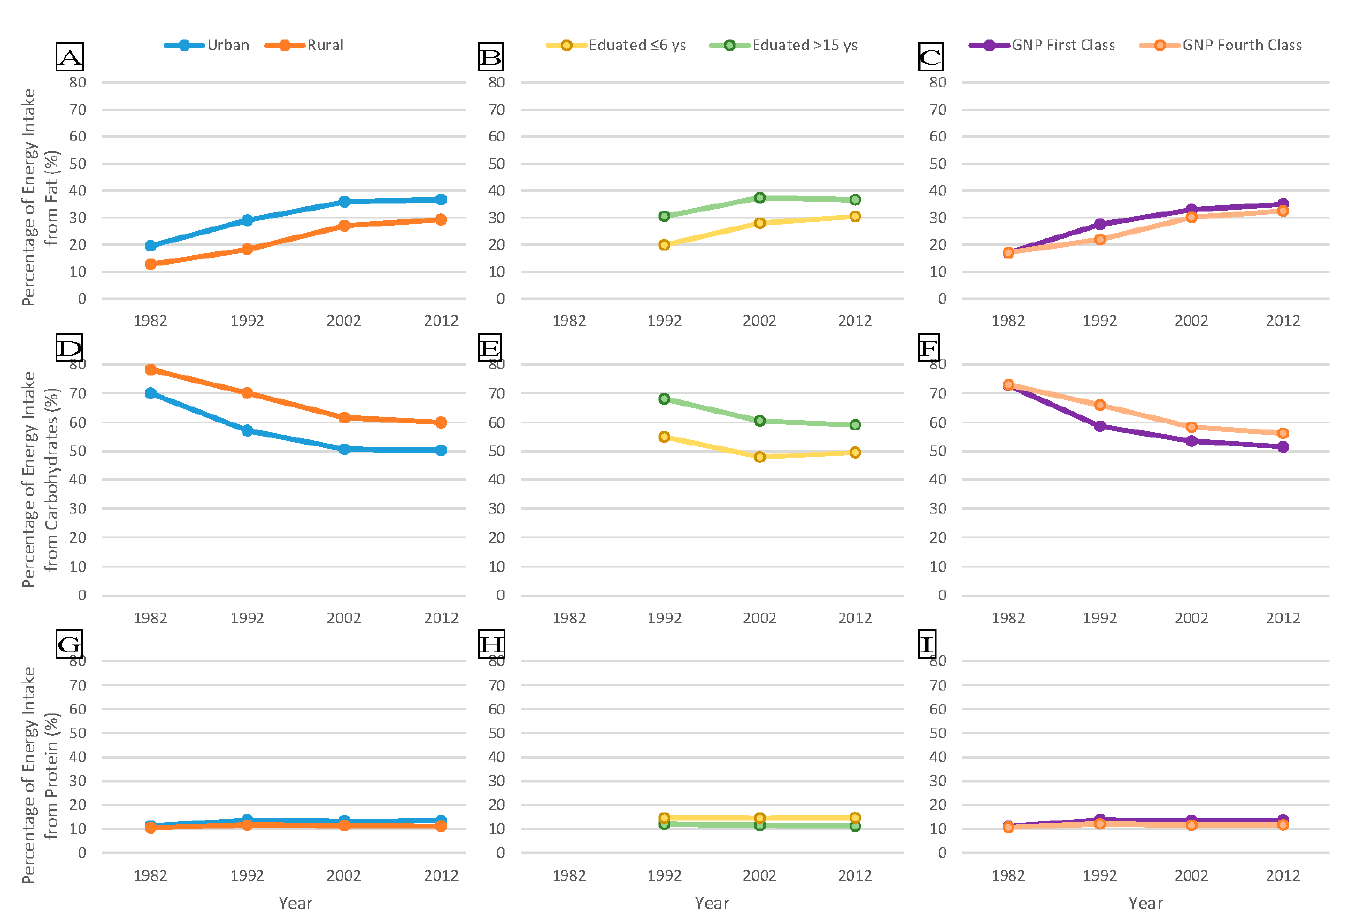
Figure 1. Trends and Disparities between Two Ends of Subgroups with regards to Estimated Energy Intake from Macronutrients of Adults Aged 18 Years or Older by CNNS Round, 1982–2012, Stratified by Area, Education Level and GNP Level. The two polygonal lines in each graph represent the two ends of subgroups. ( A – C ) show percentages of energy intake from fat across survey rounds. ( D – F ) show percentages of energy intake from carbohydrates across survey rounds. ( G – I ) show percentages of energy intake from protein across survey